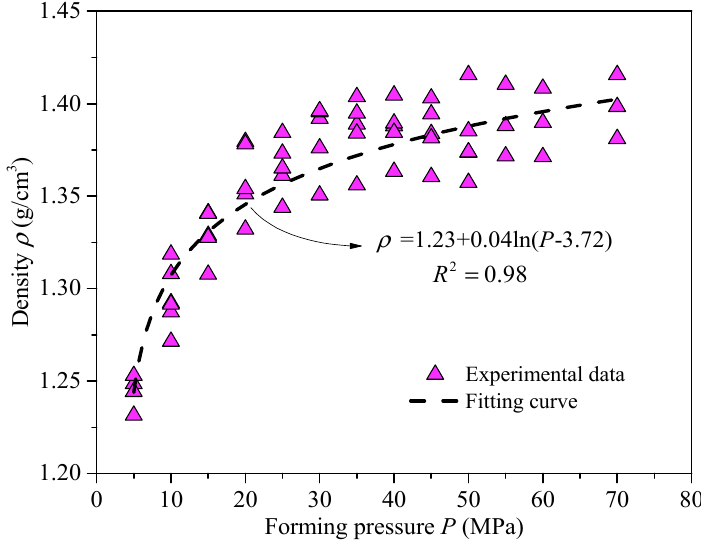
Figure 7. Relationship between density and forming pressure of RTC .